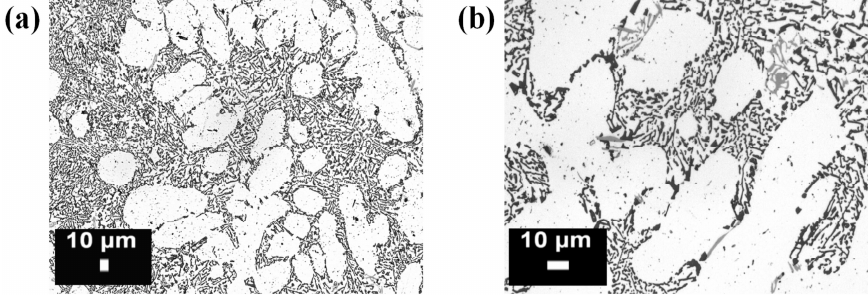
Figure 7. Optical micrographs of an AlSi10Mg alloy microstructure produced by means of casting (process,) at ( a ) low and ( b ) high magnifications: the white particles are composed of a α primary phase, while the matrix is composed of a eutectic α + Si phase (from the authors’ own unpublished work).